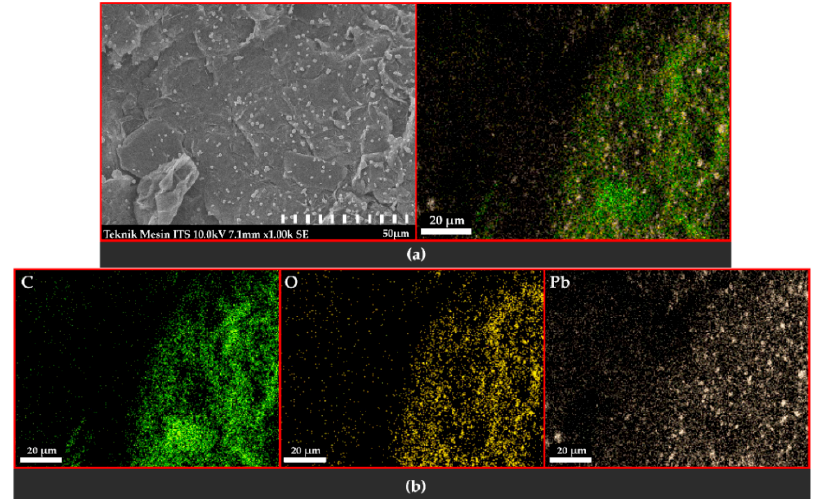
Figure 5. ( a ) Multi-element energy-dispersive X-ray spectroscopy mapping image. ( b ) Digital mapping image of elements C, O, and Pb at 6 V.